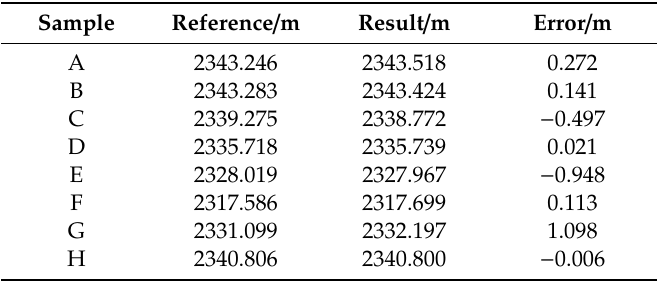
Table 5. Elevation comparison of CPs.